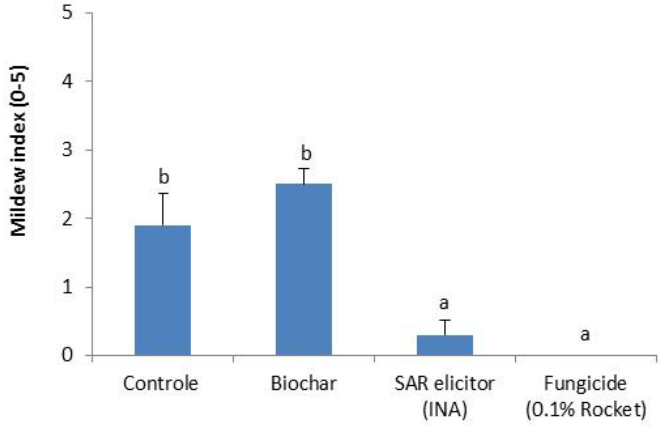
Figure 6. Symptoms of powdery mildew infection (mildew index) on Gerbera plants, 19 days after inoculation. Symptoms were quantified on a scale between 0 and 5 (0 = 0, 1 = 0.1%–2%, 2 = 2%–5%, 3 = 5%–20%, 4 = 20%–40%, 5 = >40%). Treatments which do not share the same letters a or b differ significantly (Tukey’s test, p < 0.05).